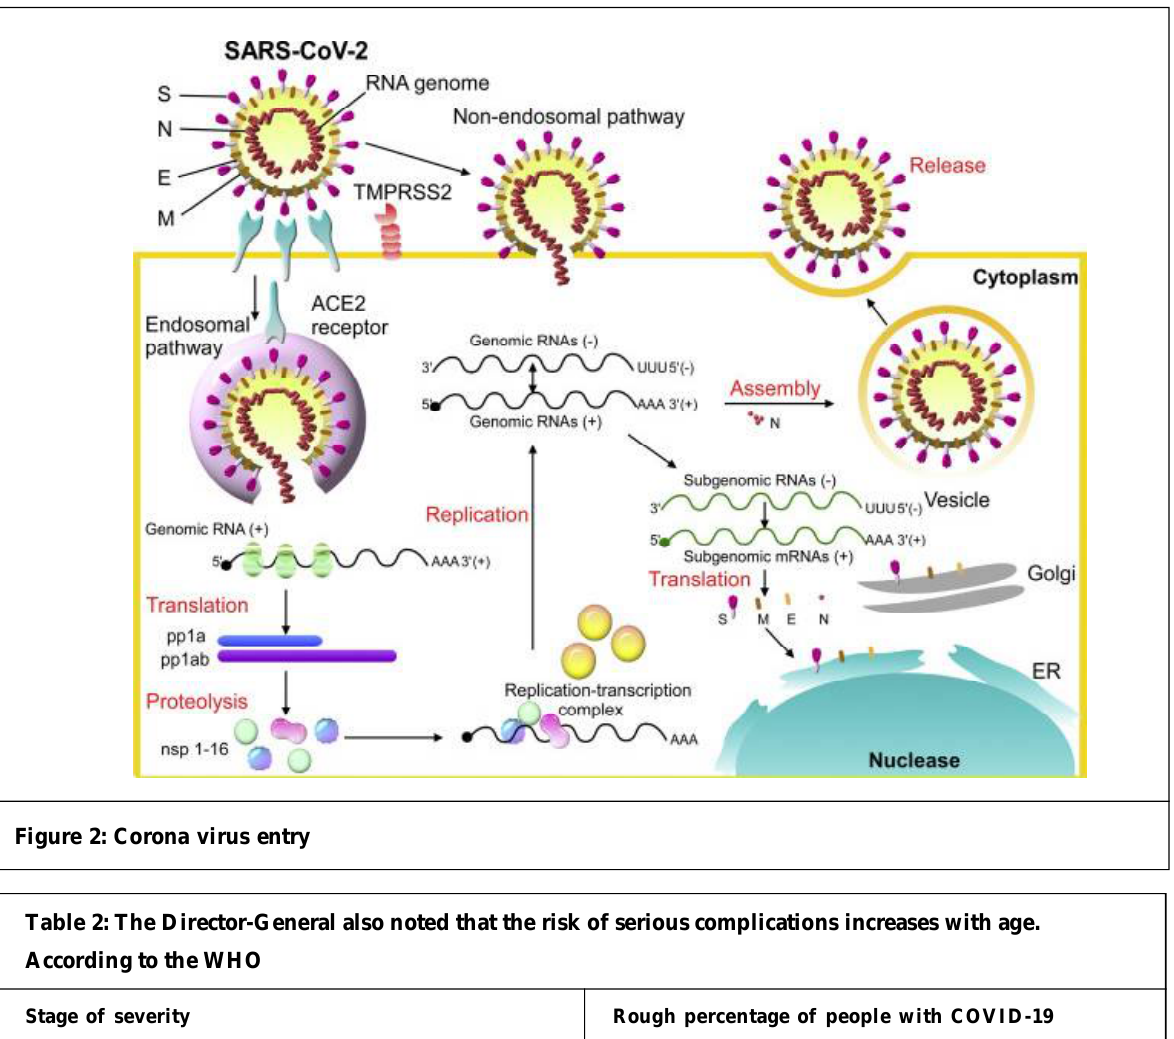
Table 2: The Director-General also noted that the risk of serious complications increases with age. According to the WHO Stage of severity Rough percentage of people with COVID-19 Mild disease from which a person can recover More than 80% Severe disease, causing breathlessness and pneumonia Around 14% Critical disease, including septic shock, respiratory failure, and the failure of more than one organ. About 5% Fatal disease